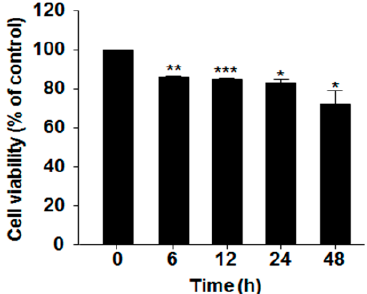
Figure 1. Effect of serum deprivation (SD) on the viability of MG-63 cells. The cytotoxic effects of SD on MG-63 cells were assessed by the MTT assay. Cells were grown in serum-free medium for the indicated time periods, and their absorbance at 540 nm was measured on an enzyme-linked immunosorbent assay (ELISA) reader. The results are expressed as percentages of cell proliferation in the control (0 h) and represent the means ± SEM of three independent experiments. * p < 0.05 (compared to the control); ** p < 0.01; *** p < 0.001.